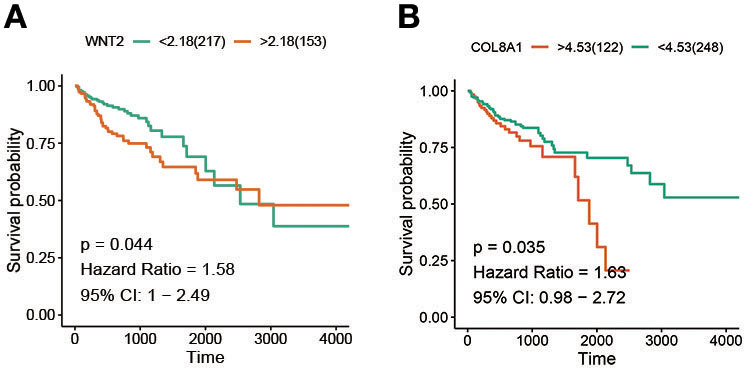
Screening of survival-related hub genes. (A) The relationship between the expression of Wnt2 and overall survival of colon cancer patients. (B) The relationship between BRAF mutation and overall survival of colon cancer patients.